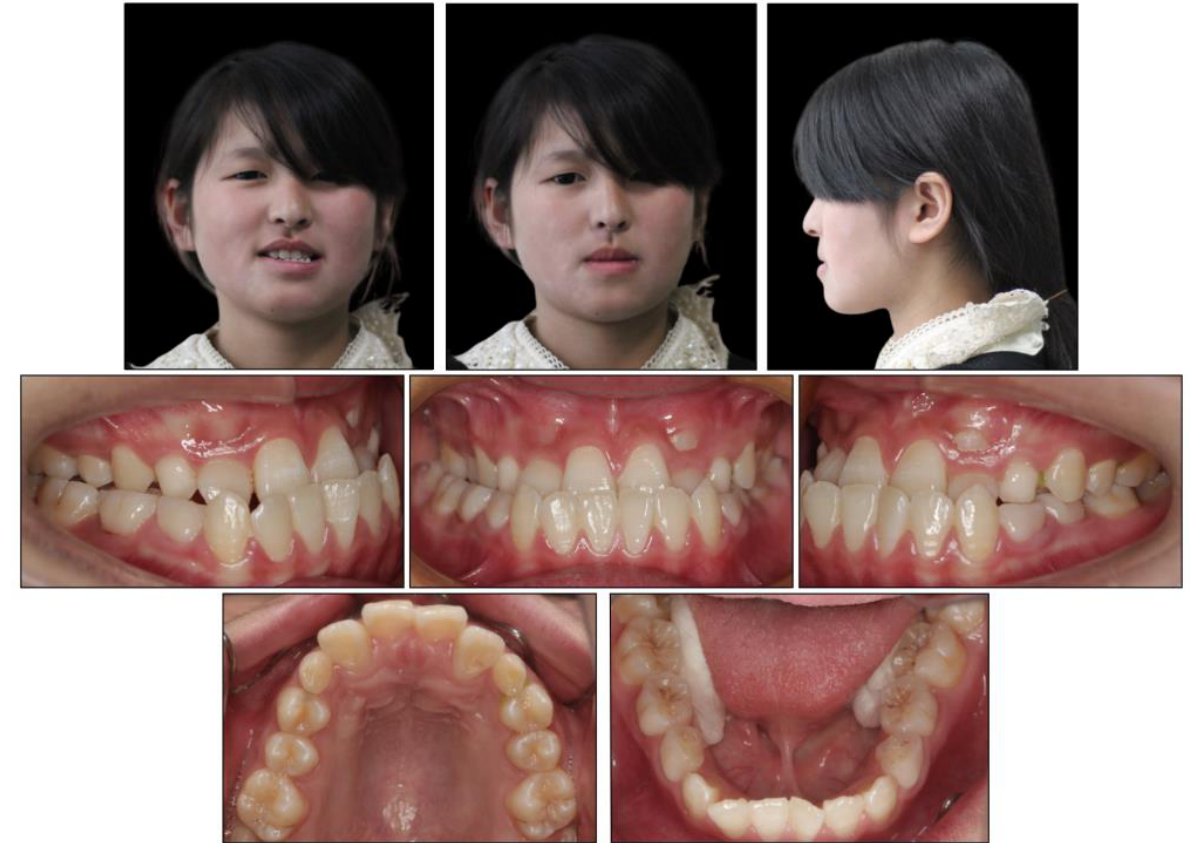
Figure 1. Pretreatment intraoral and facial photographs.